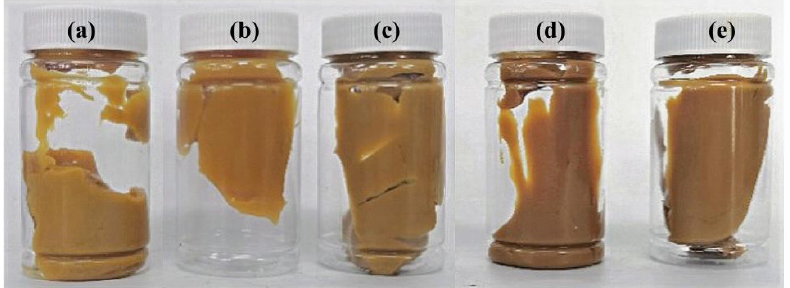
Figure 1. The schematic diagram of the synthesis process of ( a ) nanometer Ni and ( b ) Ni-doped lithium grease; ( c ) the schematic diagram of tribological test arrangement. Figure 2. Lithium grease with nanometer Ni in various concentrations (wt%): ( a ) 0, ( b ) 0.05, ( c ) 0.1, ( d ) 0.2, ( e ) 0.3.